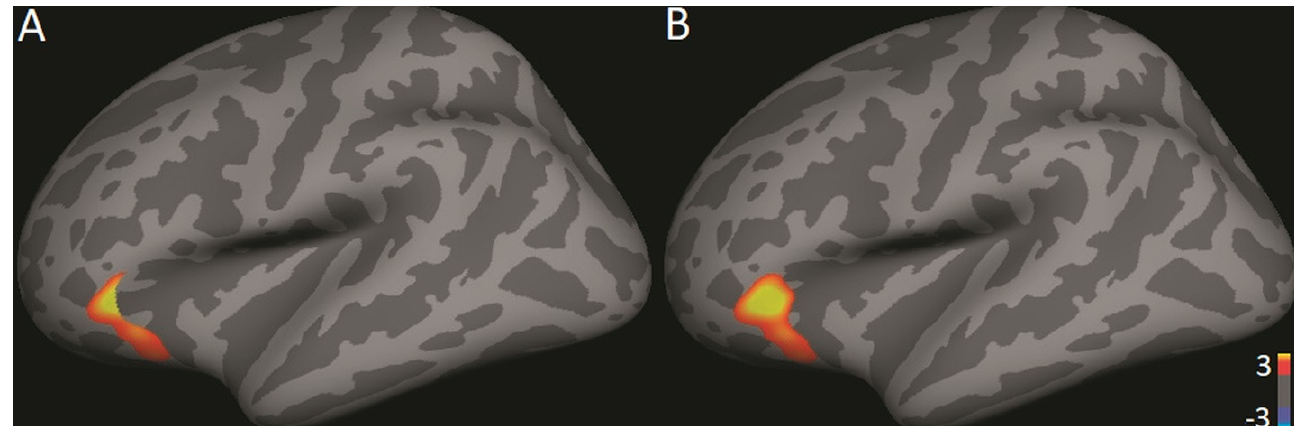
Figure 3. ( A ) Correcting within the DMN, TWS, and functional connectivity between the PCC/precuneus seed and the left IFC are significantly correlated ( p = 0.0088). ( B ) The correlation between TWS and functional connectivity between the PCC/precuneus and the left IFC survived whole brain correction ( p = 0.0269).